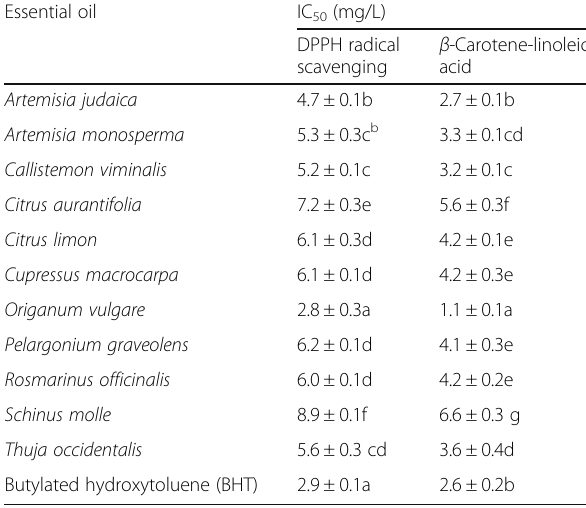
Table 2 Antioxidant activity of essential oils using the corresponding concentrations measured by DPPH and β -carotene-linoleic acid methods a Essential oil